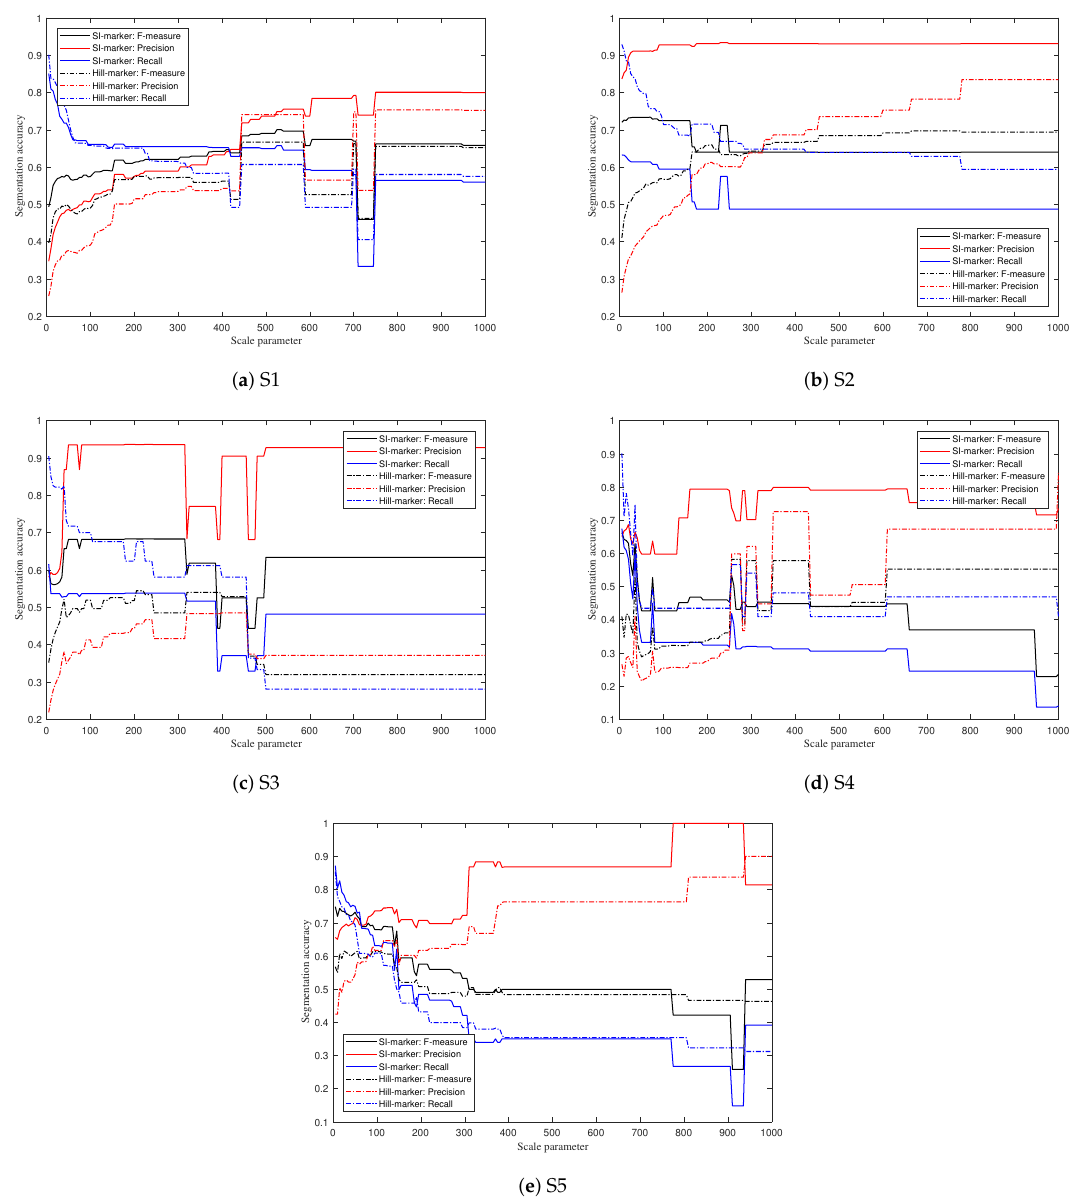
Figure 12. The F - measure , Precision , and Recall of segmentation with different scale parameters on subset image of S1 ( a ), S2 ( b ), S3 ( c ), S4 ( d ), and S5 ( e ). By comparing the five curves, one can conclude that the performance of the SI-marker method is visibly and consistently superior to that of the Hill-marker method when the scale is small. Additionally, the precision of the SI-marker method was always higher than that of the Hill-marker method, which indicates that there were more accurate